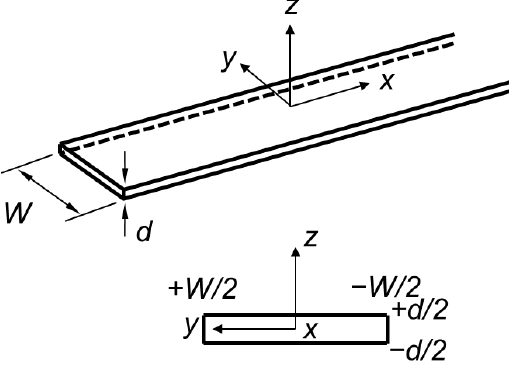
Figure 1. Coordinate system of a finite-width plate .